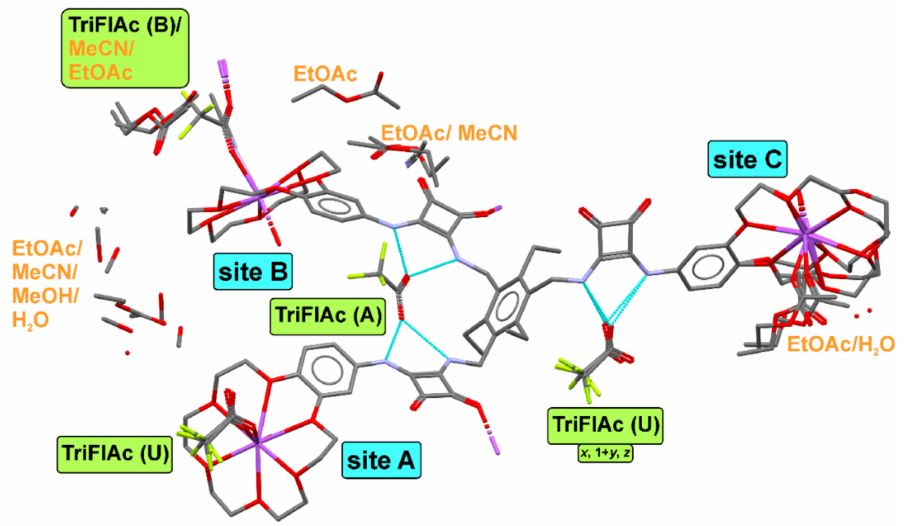
Figure 4. The asymmetric part of the unit cell of the 1 + Na_triFlAc , depicting the shape of the ligand, presenting complexation of the anions and showing mixed sites moieties. H atoms omitted for